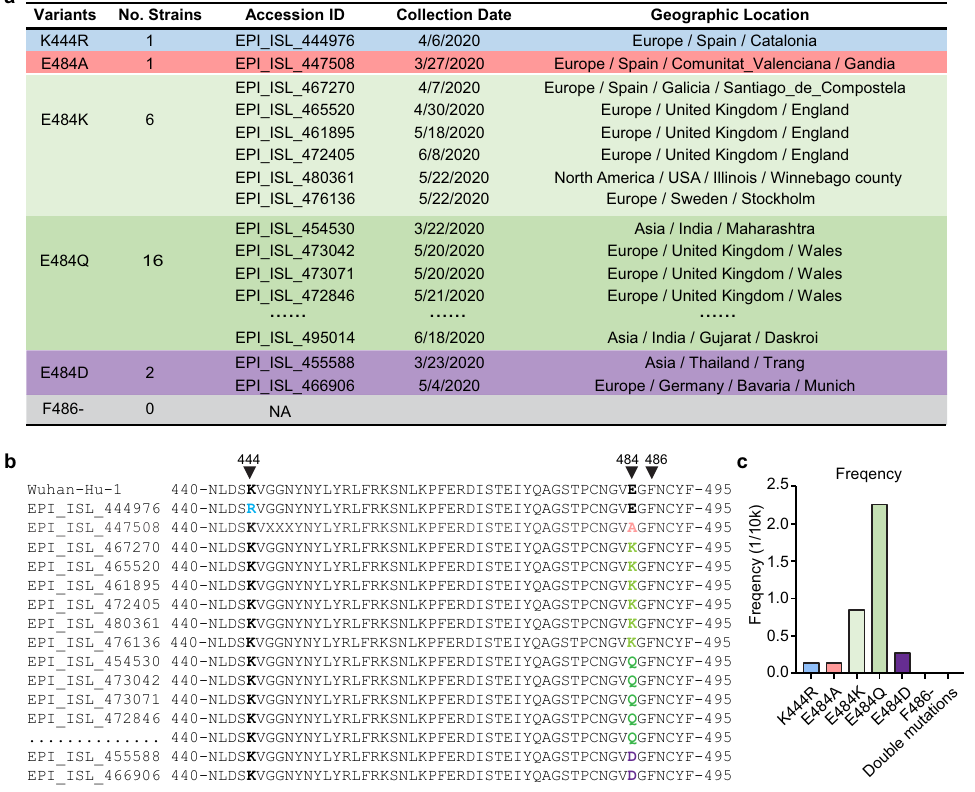
Fig. 7 Sequence analysis of SARS-CoV-2 isolates with natural mutations at the K444, E484, or F486 sites of the RBD. a Summary of total numbers, accession ID, collection date, and geographic locations for the clinical SARS-CoV-2 isolates with indicated mutations. A total of 70,943 viral genome sequences were queried from GISAID and analyzed. b Alignment of the RBD sequences of the mutant viruses with the reference Wuhan-Hu-1 strain. c Frequency of the virus variants with single mutations of the K444, E484, and F486 residues, or simultaneous mutations of K444 + E484 or K444 + F486 residues in the total analyzed viral